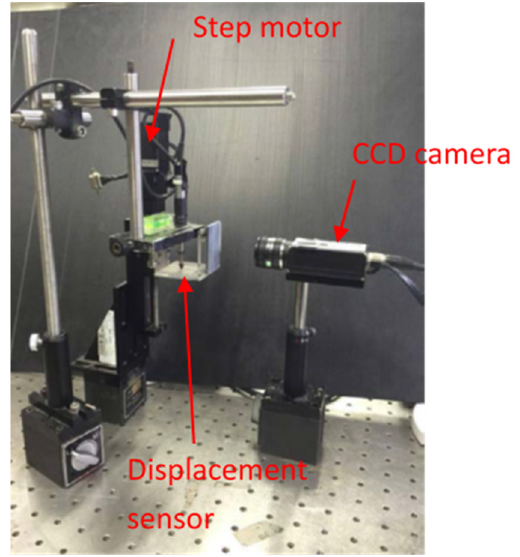
Figure 4. Experimental setup used to select subset sizes, correct image distortion, and perform rigid body translation.